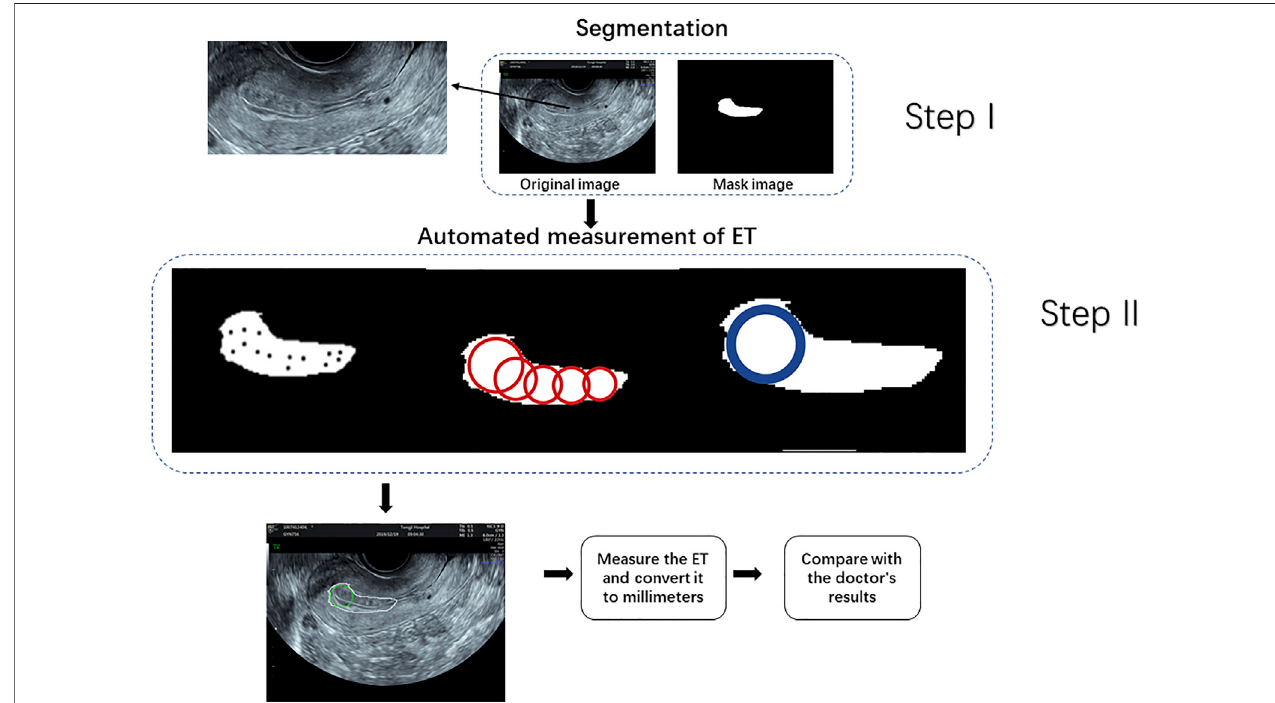
FIGURE 4 | Procedure for measuring endometrial thickness.